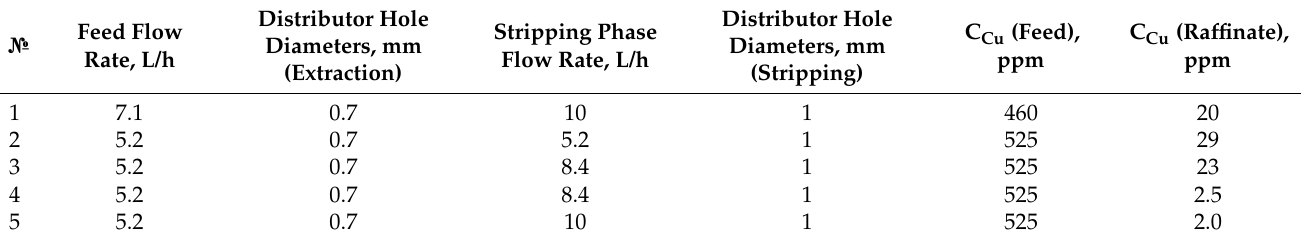
Table 4. Results of experiments conducted in apparatus 2 when vibrating sieve plates were placed in the extraction